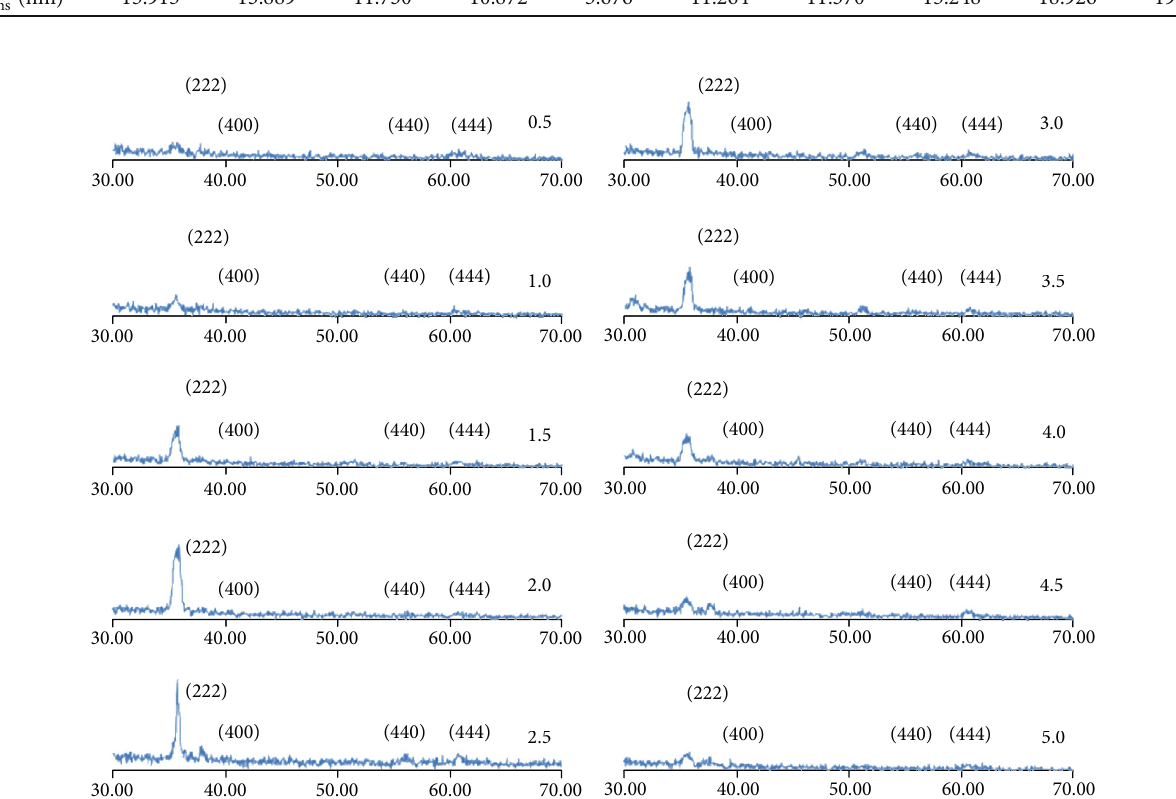
Figure 2: The XRD spectra of the ITiO fi lms with various doping concentrations, deposited at 300W of RF